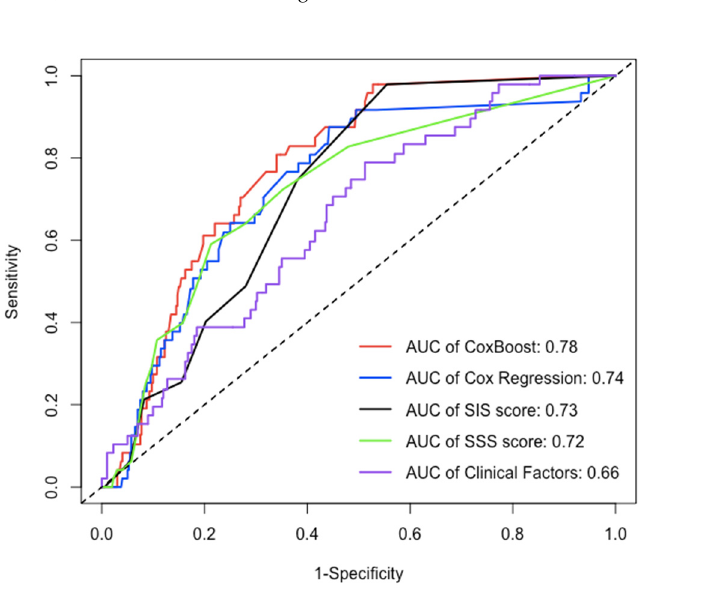
Cox regression, Cox proportional hazard regression; SIS score, segment involvement score; SIS score + clinical factors, clinical factors added to segment involvement score.